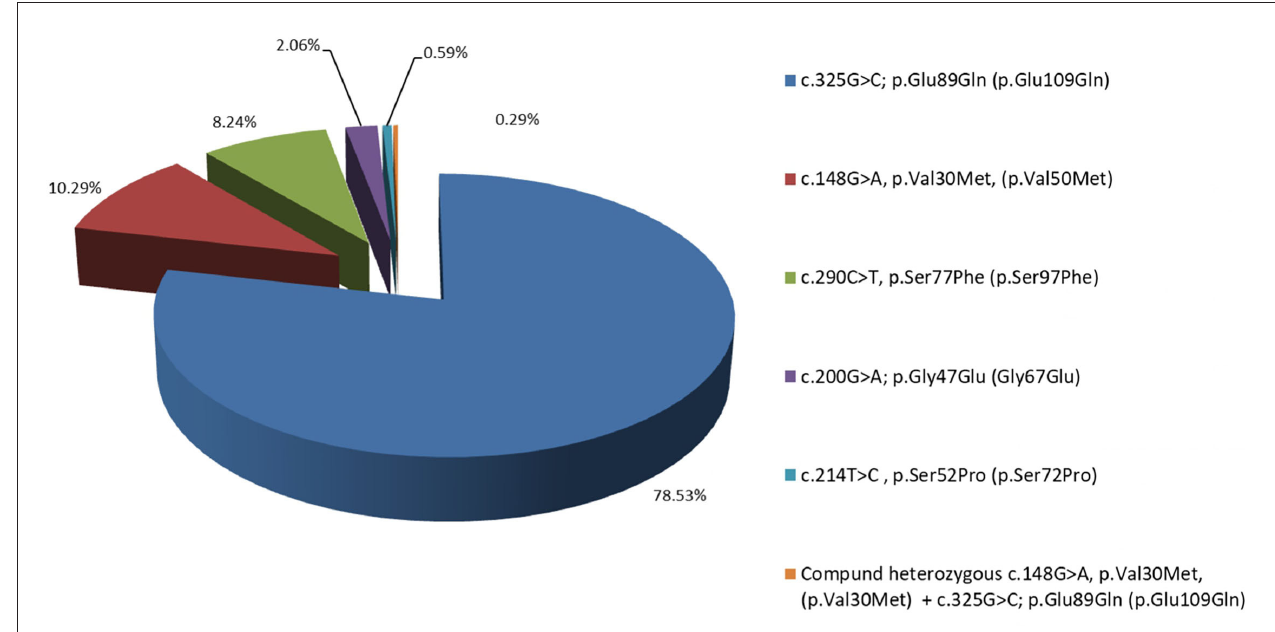
FIGURE 1 | Distribution in percentage of the Bulgarian hereditary transthyretin amyloidosis (ATTRv) patients, according to their mutation: 78.53% with Glu89Gln, 10.29% with Val30Met, 8.24% with Ser77Phe, 2.06% with Gly47Glu, and 0.59% with Ser52Pro.